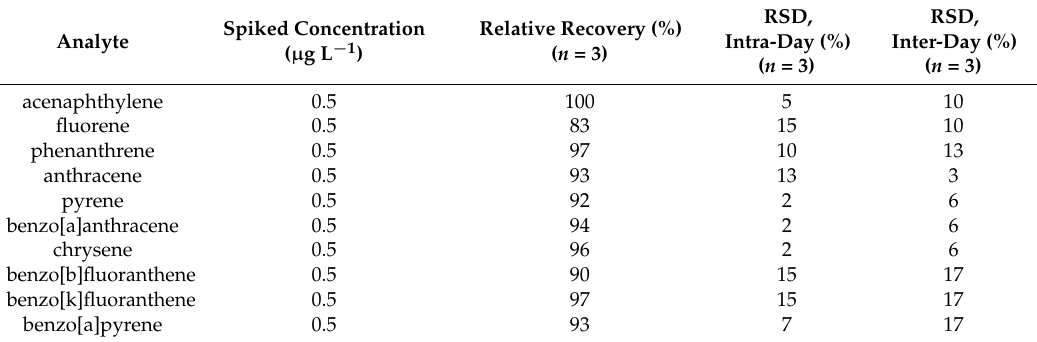
Table 3. Relative recovery of analytes and precision (inter- and intra-day) for the extraction of PAHs from spiked river water